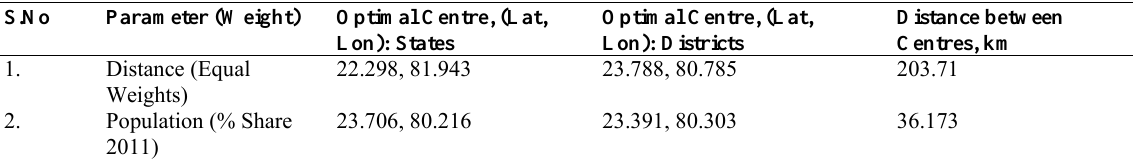
Table 6 Distance between Optimal Centres: States and Districts